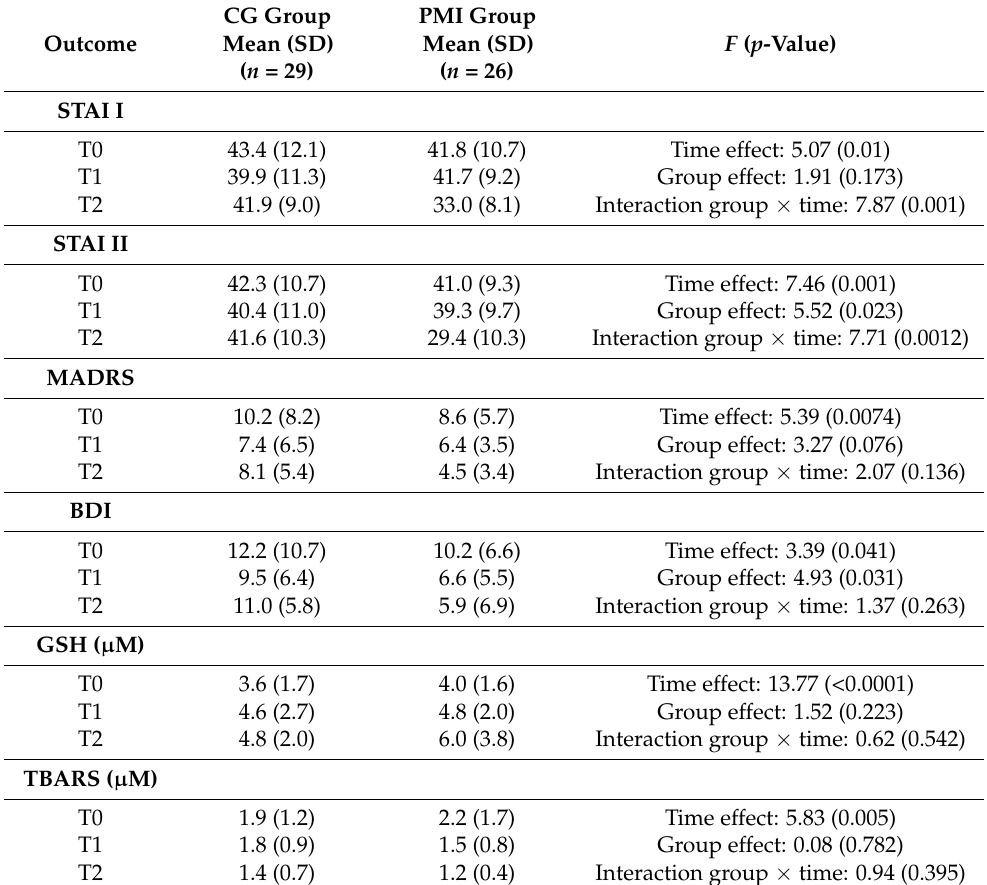
Table 3. Key secondary outcomes: anxiety (STAI I and STAI II), depression (MADRS and BDI), and plasma redox status parameters (GSH and